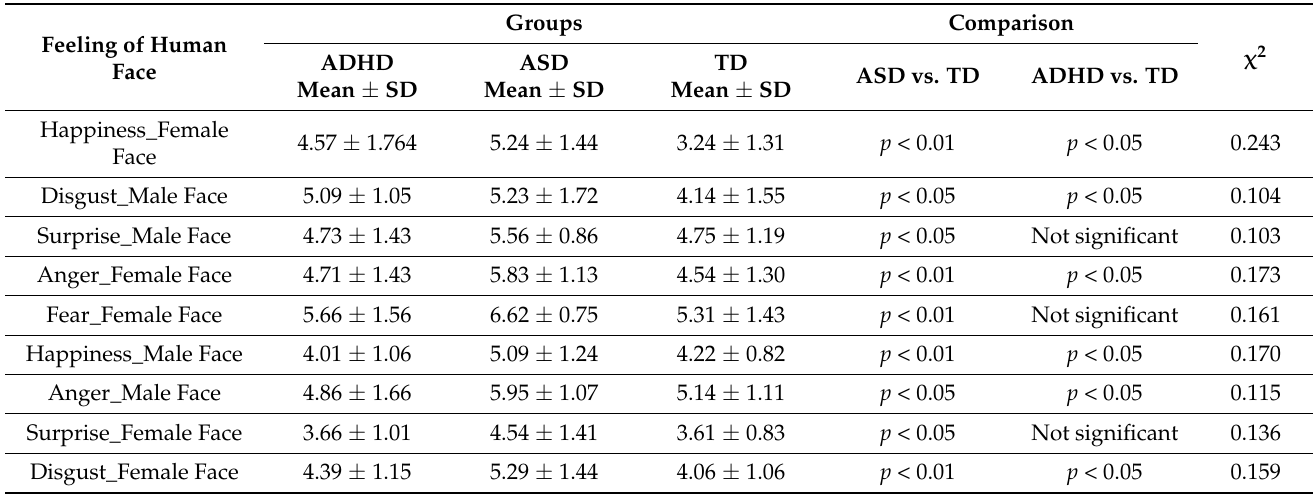
Table 2. Post hoc comparison: diagnostic groups × latency morphing human faces.